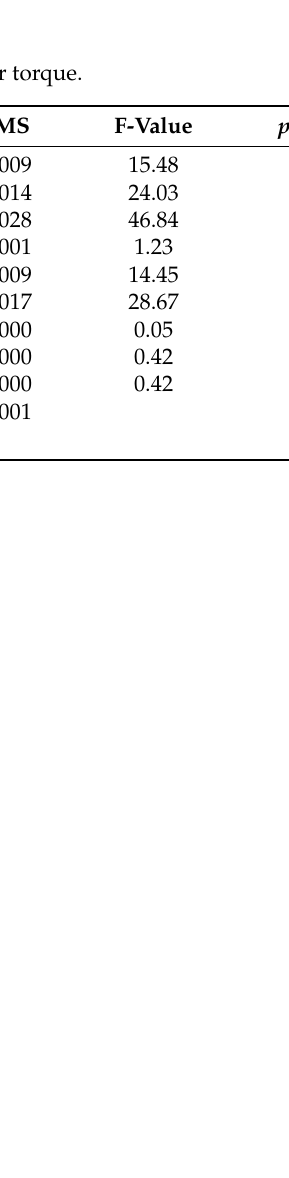
Figure 13. Desirability chart of design variable for optimization to maximize torque and minimize OASPL. Table 9. Comparison of standard model and optimal model.